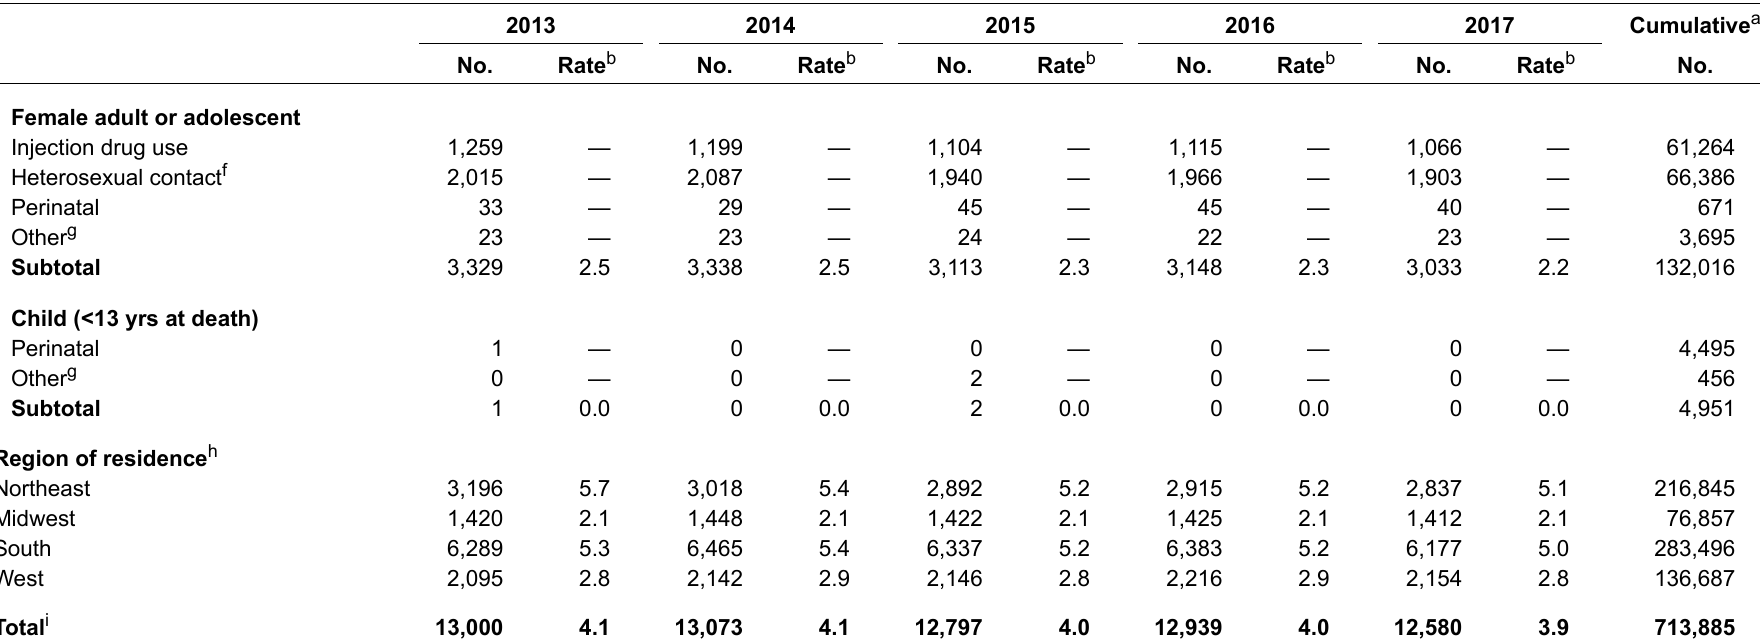
Table 19a. Deaths of persons with diagnosed HIV infection ever classified as stage 3 (AIDS), by year of death and selected characteristics, 2013–2017 and cumulative—United States